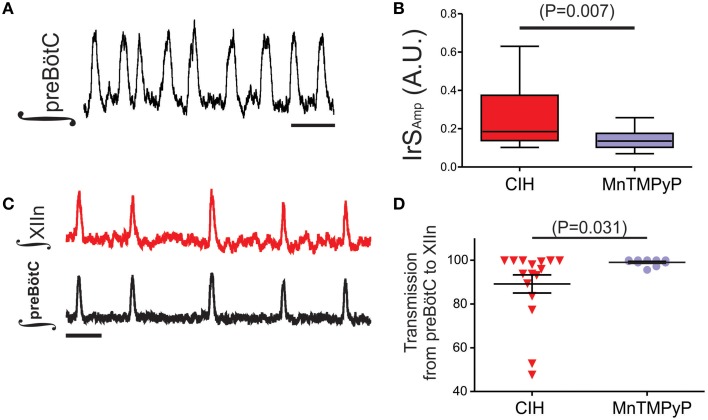
MnTMPyP treatment reduces CIH-mediated amplitude irregularities within the preBötC and preserves rhythm generation in Xlln. (A) Individual example of rhythmogenesis from the preBötC following MnTMPyP treatment during CIH. Scale Bar: 4 s. (B) Summarized comparison of IrSAMP illustrating the difference between preBötC rhythms exposed to CIH alone (n = 20) or treated with MnTMPyP during CIH (n = 18). (C) A representative trace from a subset of experiments (n = 10) where simultaneous recordings from the preBötC and XIIn following MnTMPyP treatment during CIH were made. Scale Bar: 4 s. (D) As summarized in the plot, transmission from preBötC to XIIn is restored following MnTMPyP treatment during CIH when compared the CIH group.